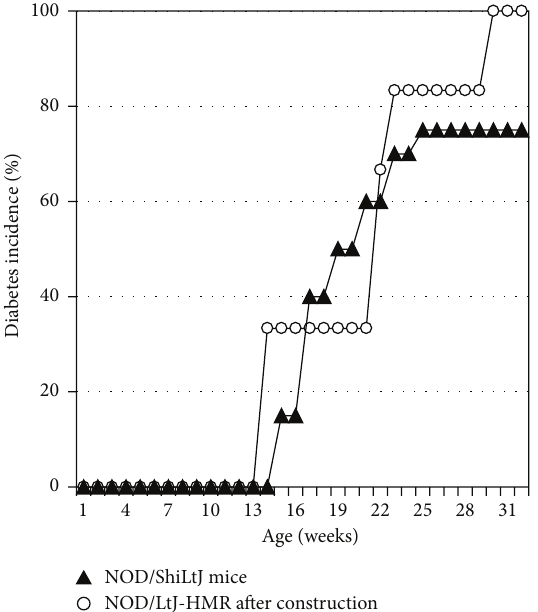
Figure 2: The lower incidence of diabetes is not due to a genetic drift in our colony. The onset of diabetes was monitored in six female NOD mice from the NOD/LtJ-HMR mouse colony born more than two months after the construction had been completed (open circles)aswellasfromtwentyfemaleNOD/ShiLtJmiceboughtfrom Jackson Labs and maintained at the HMR facility (closed triangles). The cumulative diabetes incidence shows no difference between these two colonies. Log-rank test, P value =